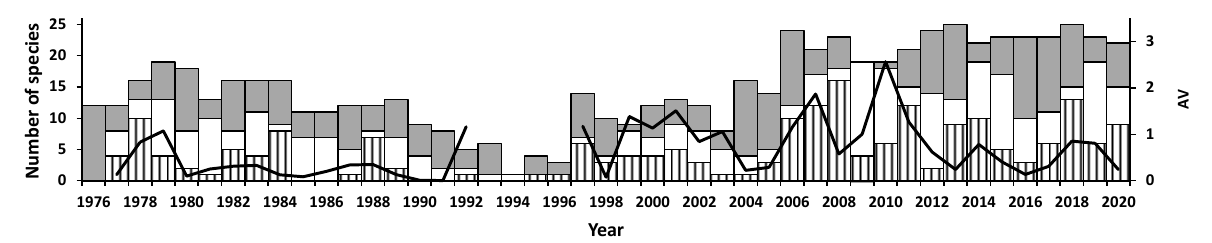
Figure 4. Number of focal species recorded increasing (hatched), decreasing (white), or maintaining (grey) abundance in different study years. The line graph shows annual variation (AV).